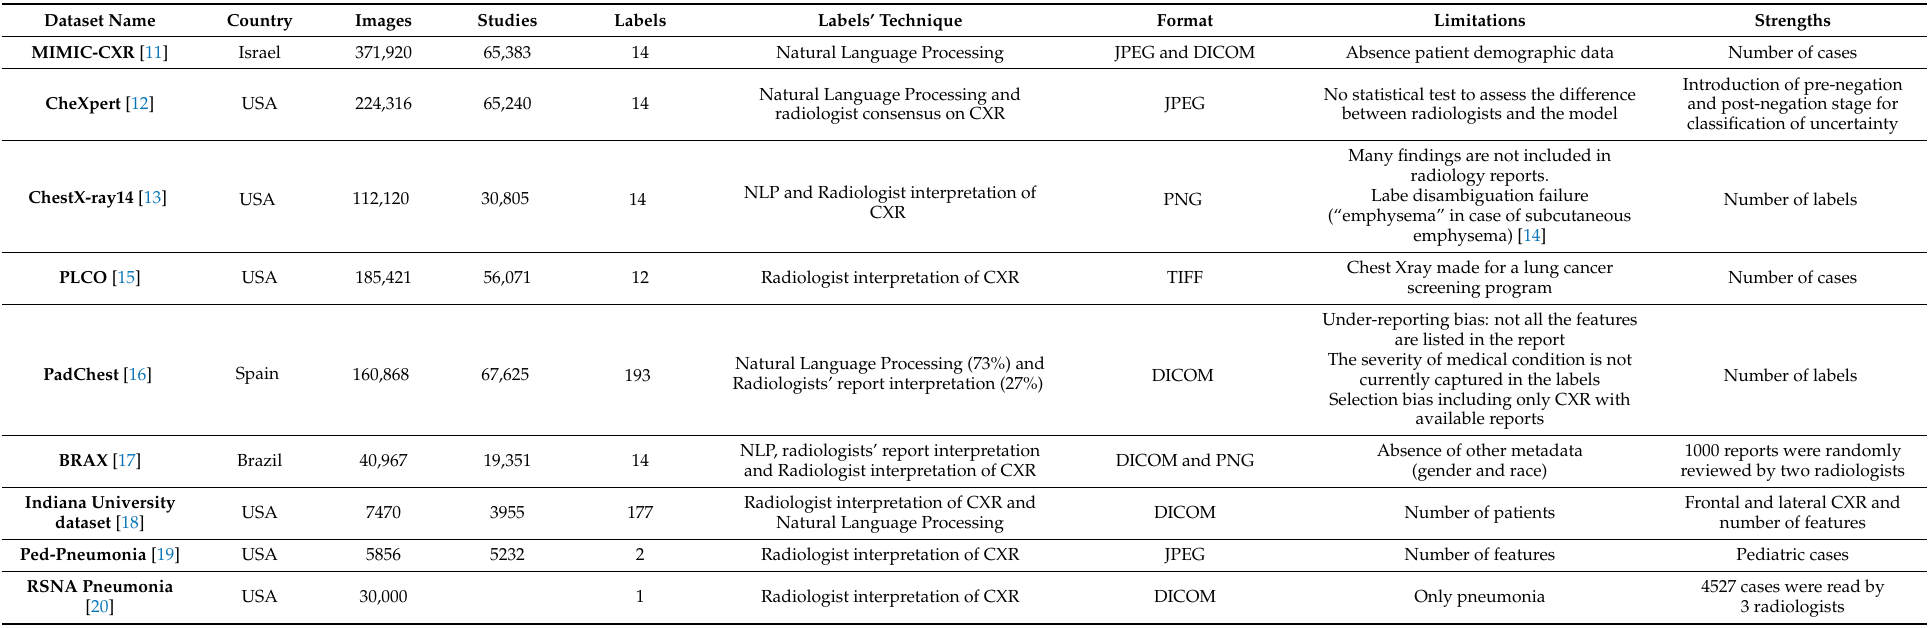
Table 1. The table summarizes the characteristics of the main CXR datasets such as the number of images, number of labels, and labeling technique. The dataset containing more images is the CheXpert with 14 labels. In the last two columns, we have listed the main strengths and weaknesses of the different